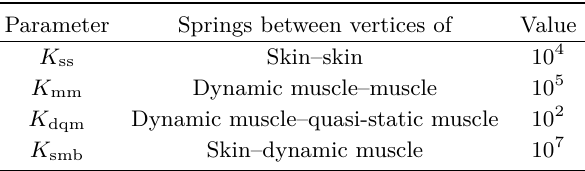
Table 1 Types of springs and their global parameters Parameter Springs between vertices of Value K ss Skin–skin 10 4 K mm Dynamic muscle–muscle 10 5 K dqm Dynamic muscle–quasi-static muscle 10 2 K smb Skin–dynamic muscle 10